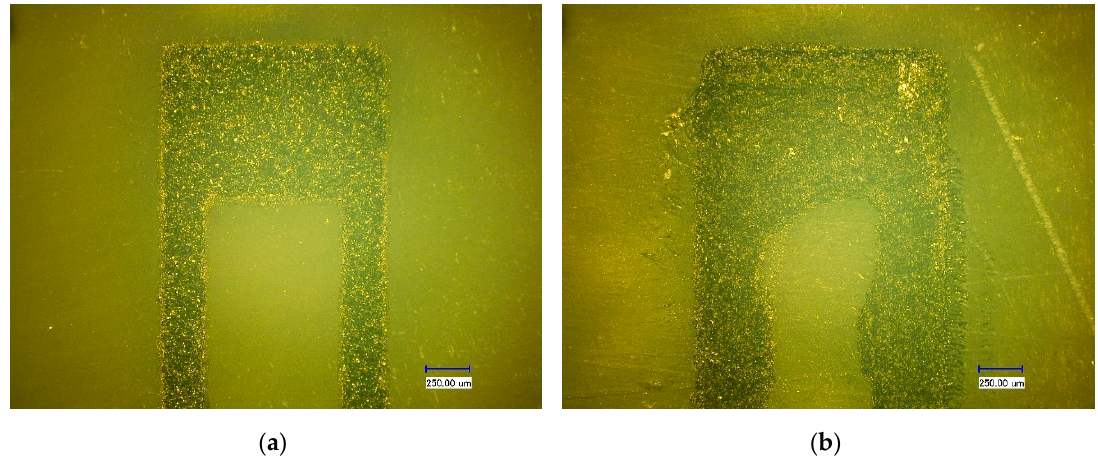
Figure 9. Microscope photos of ( a ) the screen-printed strain gauge; and ( b ) the DIW strain gauge.